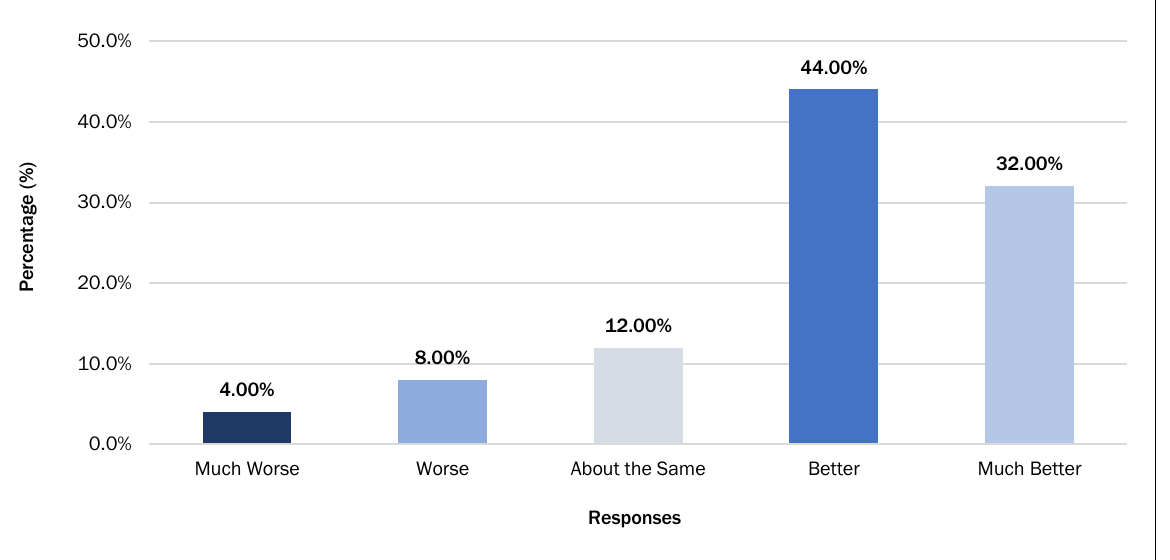
Figure 7. Impacts of COVID-19 on Small- and Very-Small – Scale Meat Processors ( N